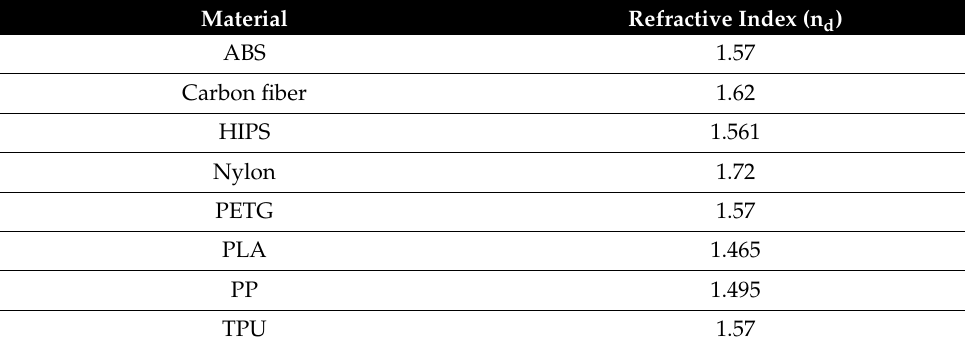
Table 2. Refractive index of thermoplastics materials.